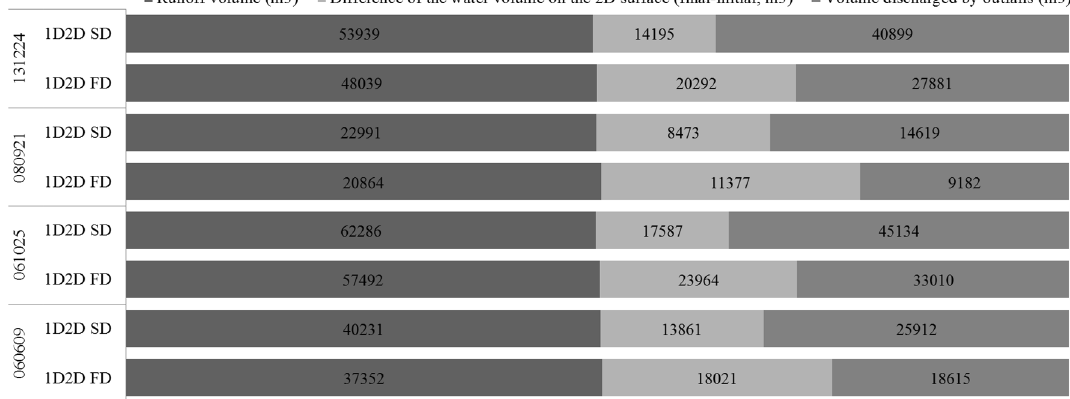
Figure 11. Volumes balance for the Zona Central case study model runs.